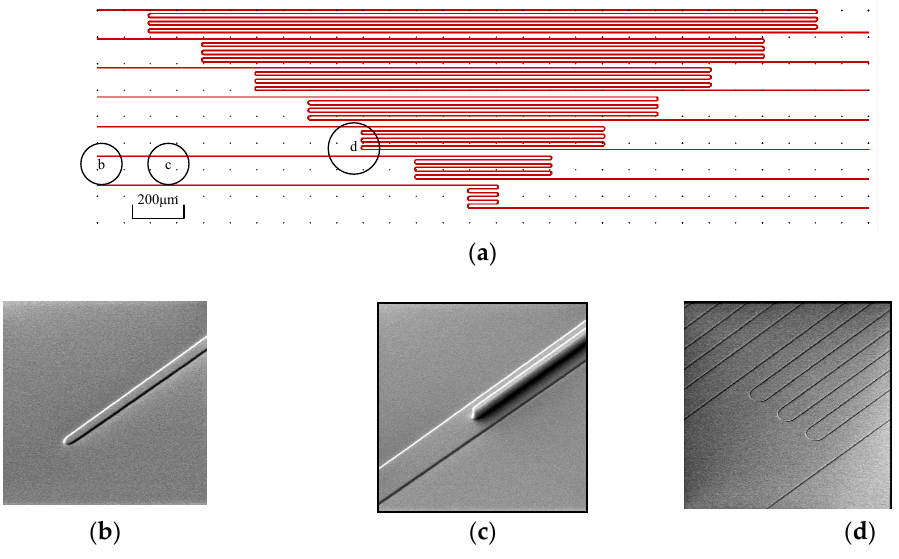
Figure 3. ( a ) SiGe waveguide layout, ( b ) tip waveguide, ( c ) the couple of SiGe waveguide and tip waveguide, ( d ) SiGe waveguide bending structure.